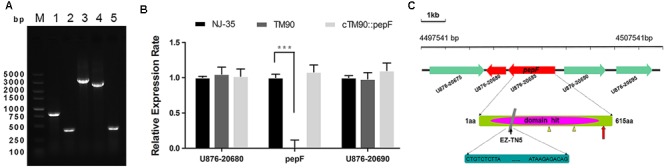
(A) Conformation of the pepF mutant strain TM90 and its complementation strain. Lane M: DL5000 DNA Marker. Lanes 1 and 2: PCR amplification using primer pairs specific for the EZ-Tn5 transposon (Tn-F/R) and the A. hydrophila strain (iolE-F/R) confirmed the reliability of the mutant strain TM90 by showing an 826 bp fragment of EZ-Tn5 and a 401 bp fragment of iolE, respectively. Lanes 3–5: The pMMB07 plasmid (3201 bp), pepF (2555 bp) and iolE (401 bp) were amplified, demonstrating the successful construction of the complementation strain cTM-90::pepF. (B) The mRNA expression levels of the pepF upstream and downstream ORFs and the pepF ORF itself in the wild-type strain NJ-35, mutant strain TM90 and complementation strain cTM90::pepF. ∗∗∗P < 0.001, indicates a significant difference in mRNA expression levels for TM90 compared with NJ-35. (C) Schematic diagram of EZ-Tn5 transposon insertion in the pepF gene. The gene cluster shows the location of the pepF gene in the NJ-35 genome. The gray rectangle shows the transposon insertion site in pepF, which is located at aa 186. The little yellow triangles indicate catalytic site residues Glu-366 and Tyr-478. The red arrow indicates the presumptive promoter of the upstream gene U876_20690.